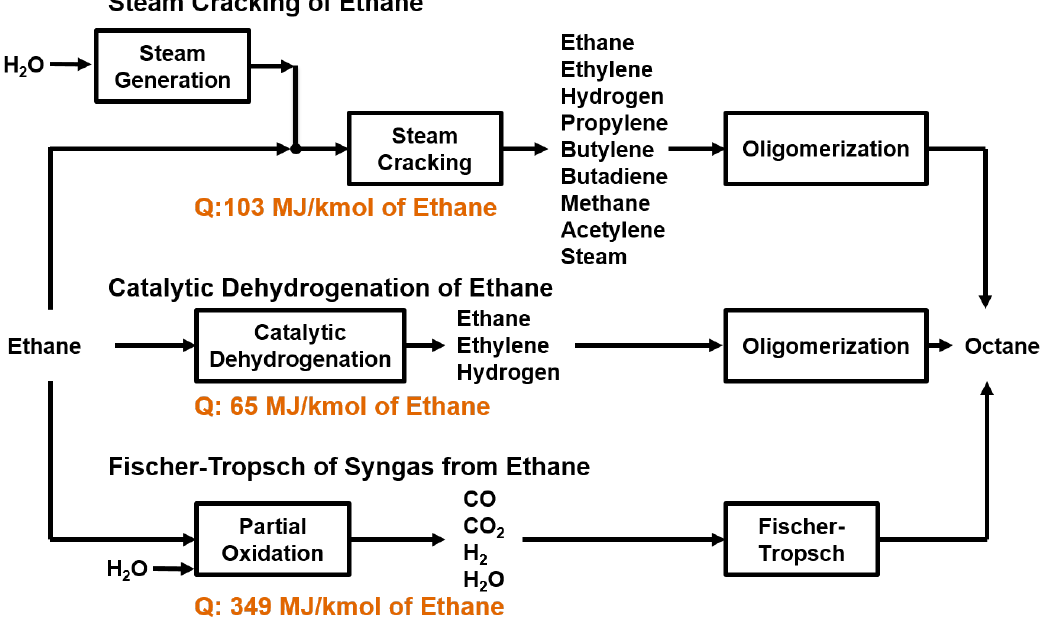
Figure 2. Three potential pathways for converting ethane to